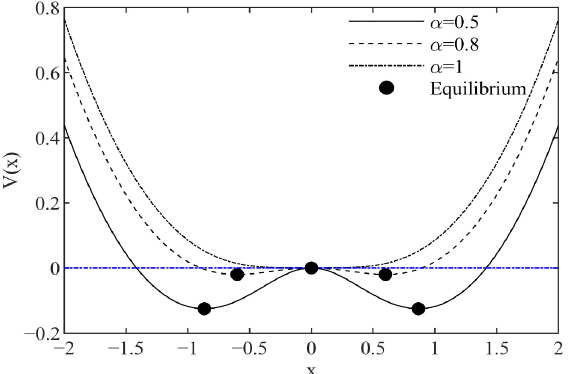
Figure 2. Potential energy of the unperturbed system (5) for di ff erent values of α .